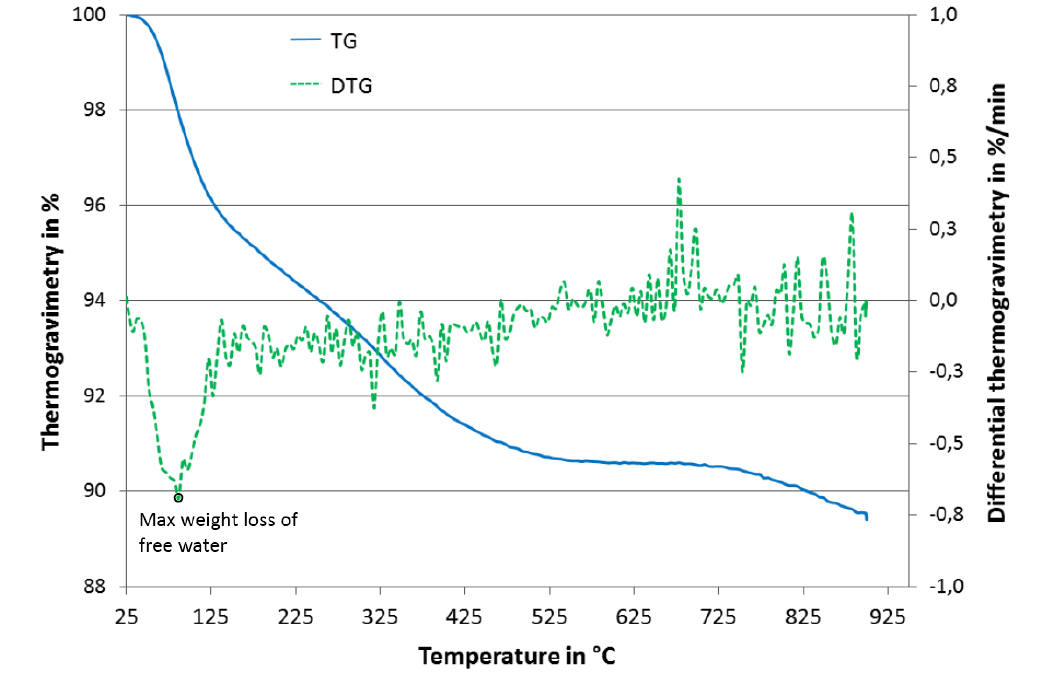
Figure 3. Thermogravimetry of alkali-activated binder